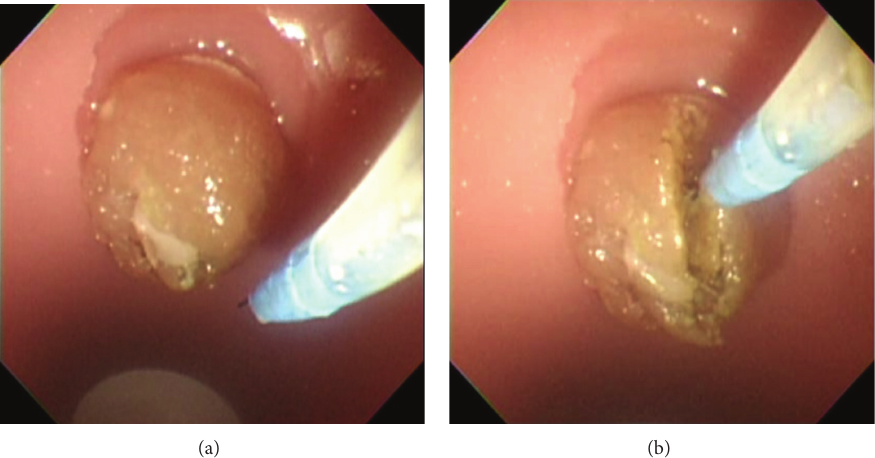
Figure 4: (a) Performance of NKP using an RX knife (Boston Scientific). (b) Performance of NKP while the cutting direction was controlled by the elevator